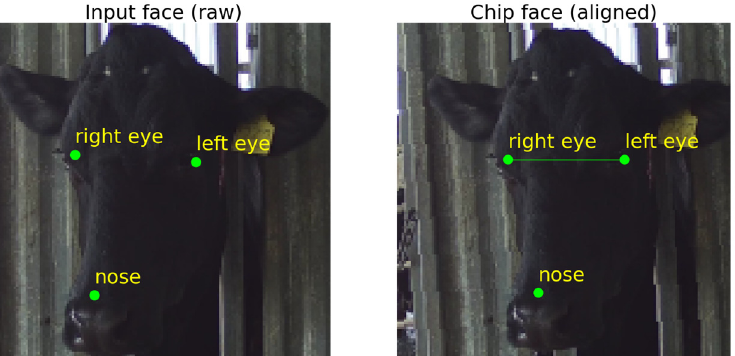
Figure 4. Example of facial landmarks prediction and aligned face.